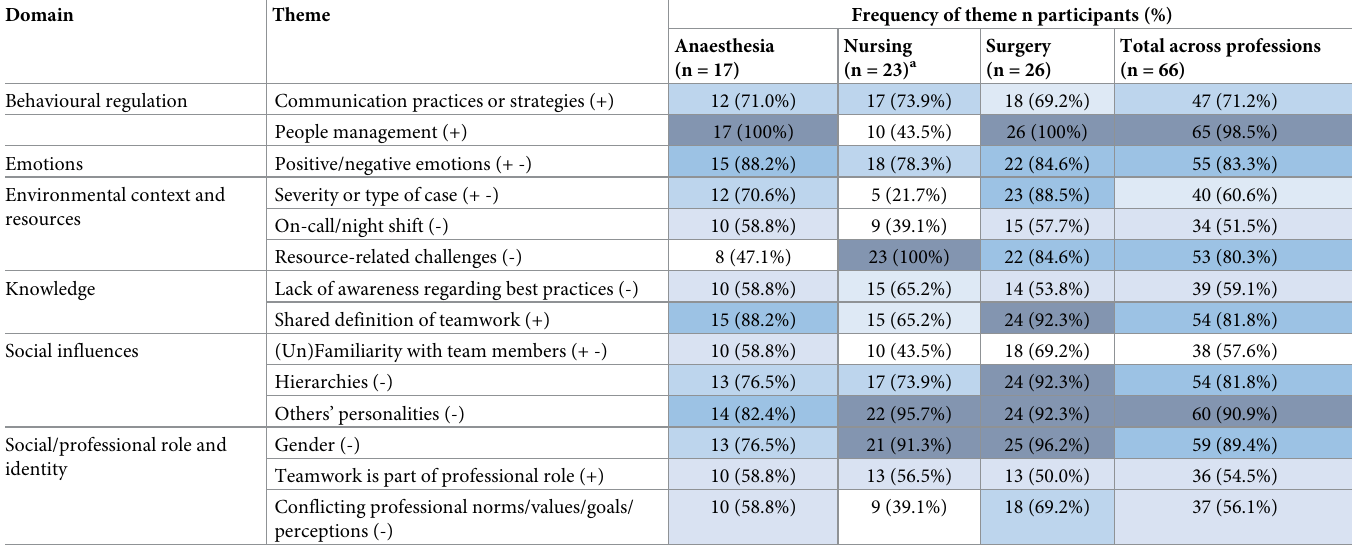
Table 2. Most frequently identified themes across relevant TDF domains �